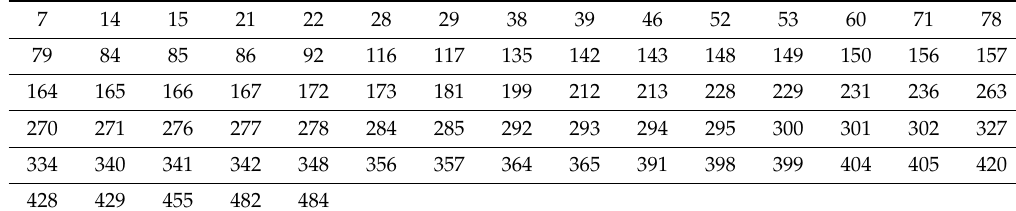
Table 9. x5 corresponding to block S texture template (decimal).